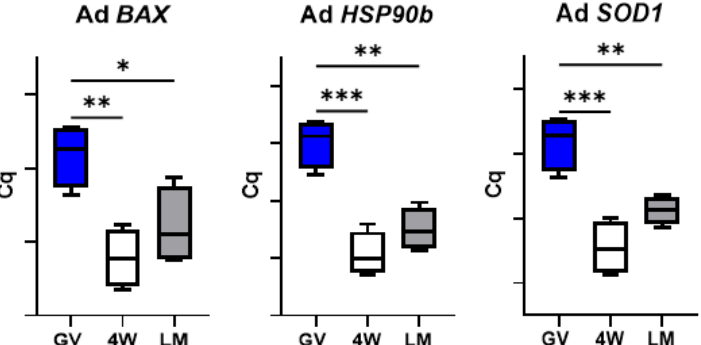
Figure 5. Expression of genes involved in cell stress response in pools of adult GV and MII oocytes matured in 4-well plates (4W) or in liquid marbles (LM). Target gene expression was normalized against the luciferase exogenous control. Relative abundance is expressed as ∆ Cq ( Y -axis). Each box represents the mean expression of 5 replicate pools of 10 oocytes each (mean ± SE). Significant differences were assessed by ANOVA general linear model test; * p < 0.05, ** p < 0.01, *** p < 0.001.